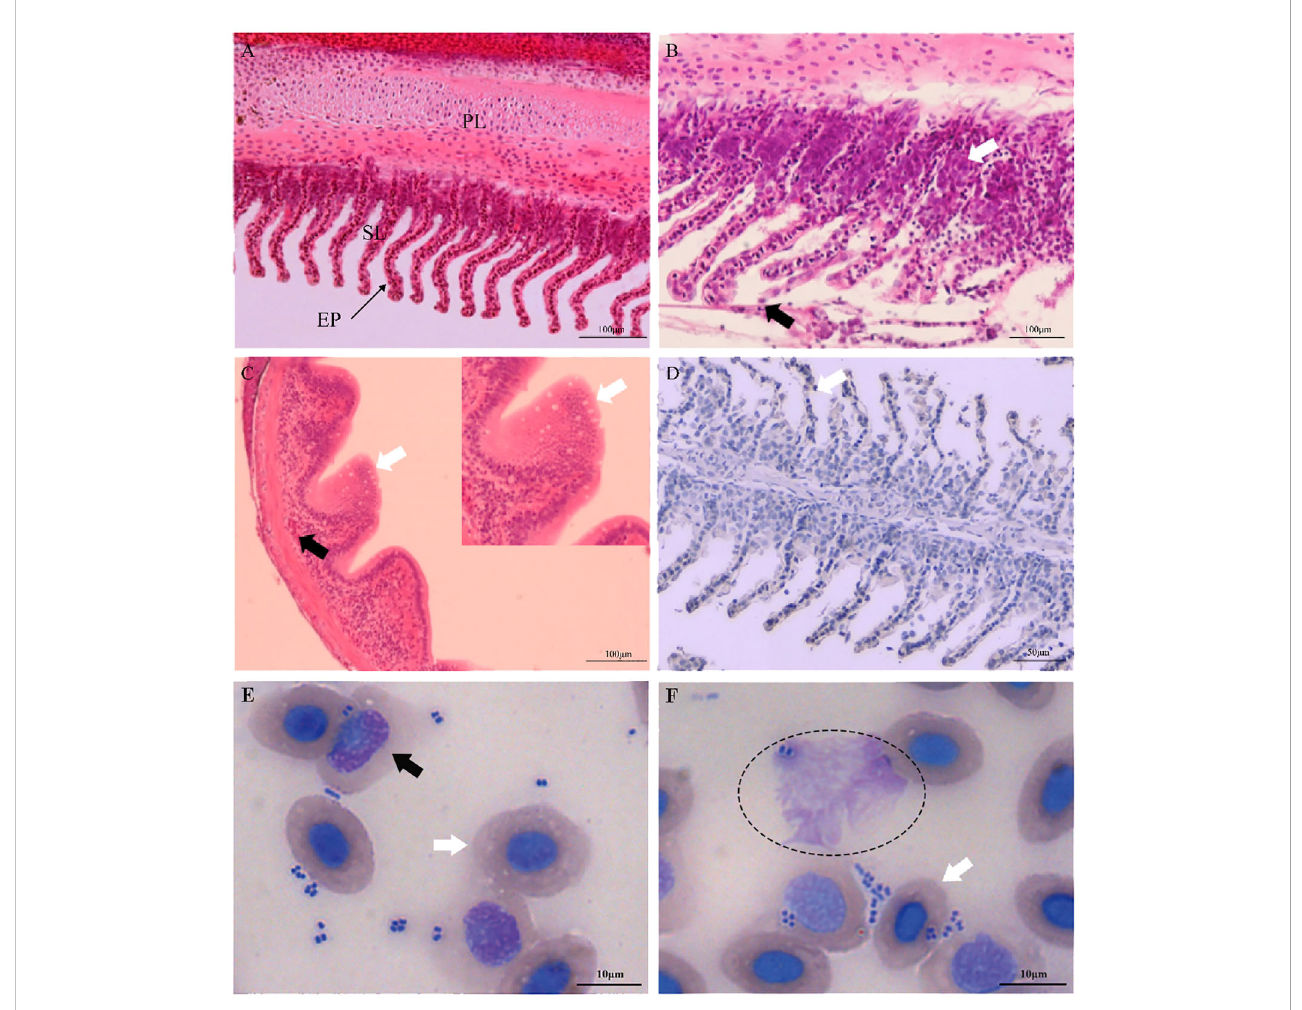
FIGURE 1 Histopathological changes and hemocyte phagocytosis of Carassius auratus infected with Aeromonas hydrophila . (A) Gills of the unexposed control fi sh. PL , primary lamellae; SL , secondary lamellae; EP , epithelial cell. (B) Exfoliation and necrosis of gill respiratory epithelial cells ( black arrow ) and extensive in fl ammatory cell in fi ltration ( white arrow ). (C) Intestinal villus atrophy, dehydration, vacuolization, and necrosis ( white arrow ), and lamina propria submucosa hemorrhage ( black arrow ). (D) Immunohistochemical staining of the gill tissues of A hydrophila , with positive staining appearing brown ( white arrow ). (E, F) Hemocyte phagocytosis of C auratus infected with A hydrophila . Phagocytic activity of A hydrophila is displayed by neutrophils ( black arrow ), macrophages ( elliptic circle ), and blood cells ( white arrow